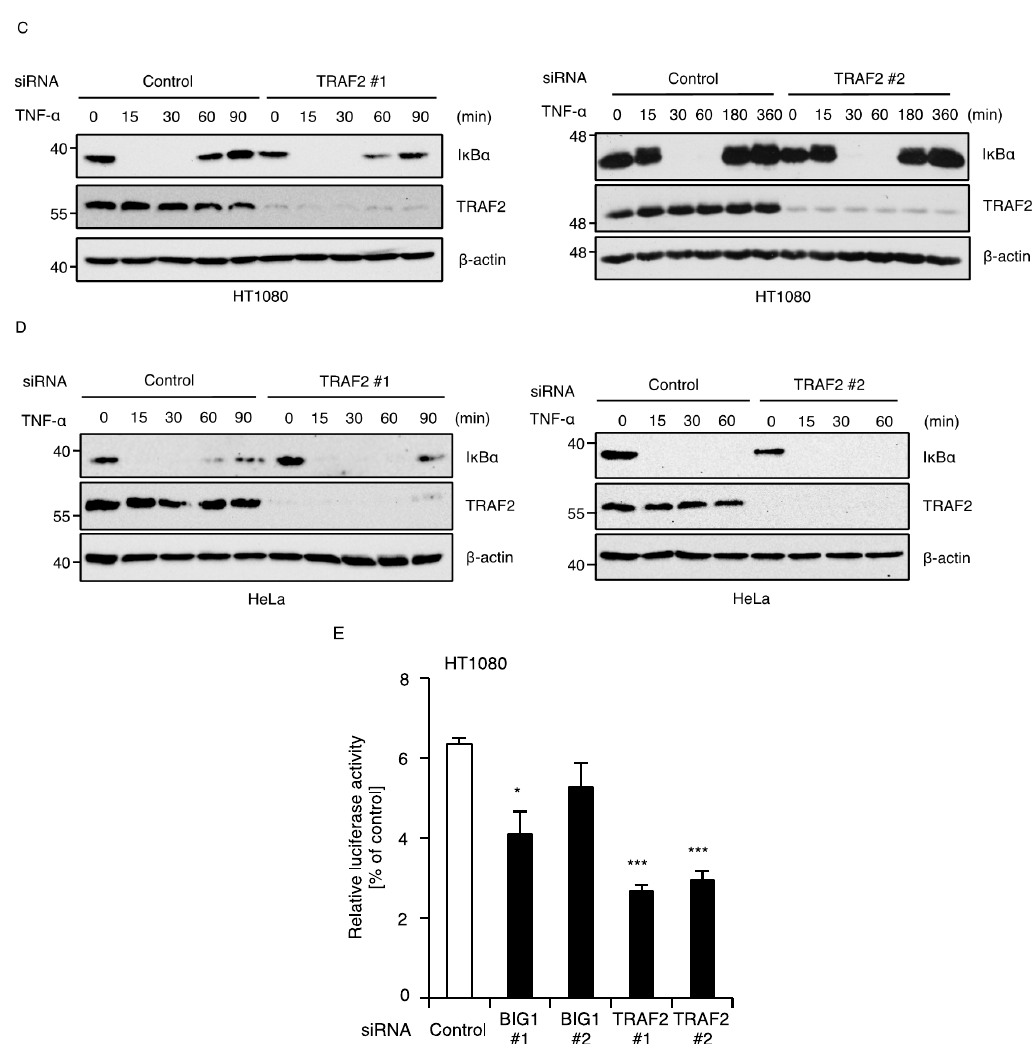
Figure 2. BIG1 is dispensable for TNF- α -induced degradation of I κ B α . ( A – D ) HT1080 ( A ) or HeLa cells ( B ) were transfected with siRNA for negative control or BIG1. HT1080 ( C ) or HeLa cells ( D ) were transfected with siRNA for negative control or TRAF2. After 72 h, the cells were treated with 20 ng/mL TNF- α for the indicated periods. The cell extracts were subjected to immunoblotting with the indicated antibodies; ( E ) HT1080 were transfected with indicated siRNA. After 24 h, the cells were transfected with a plasmid mix containing a NF- κ B luciferase reporter plasmid and a renilla luciferase plasmid for normalization together with indicated siRNA. After 48 h, cells were treated with 20 ng/mL TNF- α for 6 h. Firefly and renilla luciferase activities were quantified with dual luciferase reporter assay kit. Data shown are the mean ± SEM ( n = 3). Statistical significance was tested using an unpaired Student’s t -test (vs. control cells); * p < 0.05, *** p <